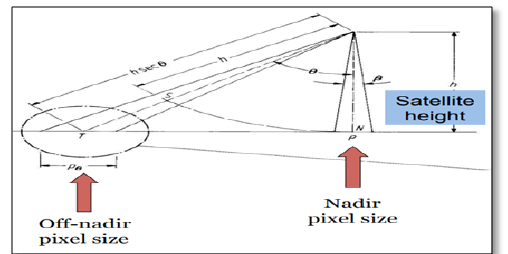
Figure 6. Spatial pixels size geometric representation in Nadir and off Nadir